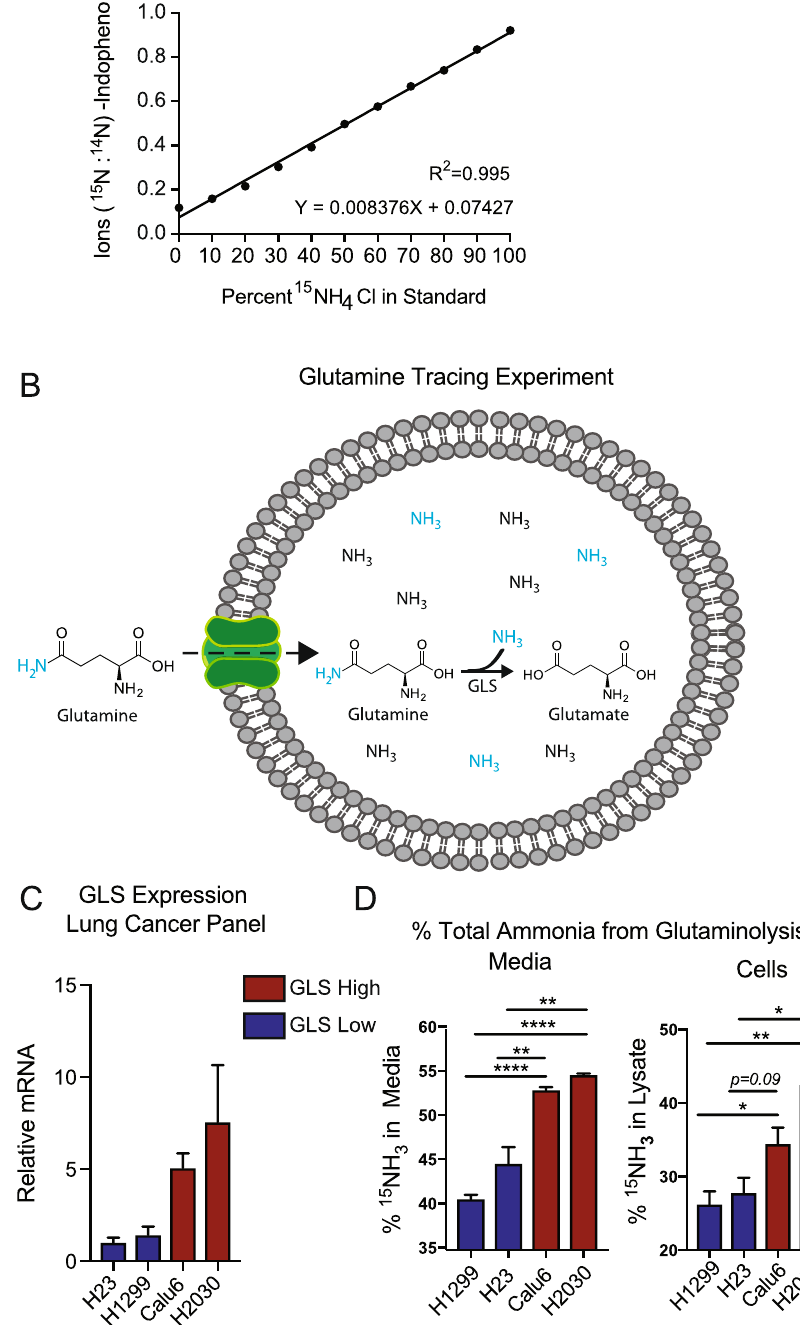
Figure 4. Application of Indophenol Assay to Quantitatively Measure Glutamine-derived Ammonia in Lung Cancer Cell Lines. ( A ) Standard curve of percent 15 NH 3 : NH 3 in a 500 μ M ammonia solution generated in cellular lysate from 293T cells treated with the Berthelot reaction. The resulting ratio of 15 N-indophenol: 14 N-indophenol are plotted as a function of the expected percent 15 N-ammonia. ( B ) Schematic of the metabolic tracing experiment to elucidate glutamine contribution to cellular ammonia pools. Blue represents the 15 N-isotope. ( C ) mRNA levels of glutaminase in lung cancer cell line panel. n = 3 replicates. ( D ) Percent 15 N-ammonia after treatment with 2.0 mM 15 N-(amide)-glutamine. Measurements were taken in the media and in cellular lysates of the lung cancer panel, n = 3 replicates per cell